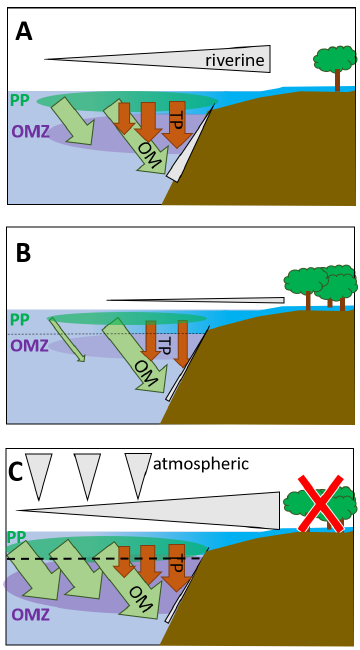
Figure 5. Schematic depiction of fluxes impacting primary produc- tion and the oxygen minimum zone in the BoB (a) during the last glacial maximum (modified from Contreras-Rosales et al., 2016), (b) currently (c) and in a scenario leading to an anoxic OMZ. The latter would require higher nutrient fluxes from the atmosphere, from upwelling, or from rivers and land. Fluxes from land may increase, e.g., from deforestation or enhanced rainfalls; however, higher terrigenous particle load would likely accompany increased nutrient loads, and therefore, even if coastal primary production would increase, export production would increase via ballasting, too. The effect on the OMZ would then be rather small. Upwelling- dependent nutrient pumping is unlikely to increase due to warming and enhanced stratification but may occur in particular in eddy sys- tems, i.e., as eddy pumping. Grey triangles depict nutrient fluxes from land and rivers, from upwelling along the shelf, and from the atmosphere. Brown arrows depict terrigenous particle fluxes as imported from rivers and leading to ballasting and enhanced or- ganic carbon export. Green arrows depict organic material exported from the photic zone primary production (green bubble, PP) into the OMZ (purple bubble). Sizes of triangles, arrows, and bubbles qualitatively indicate